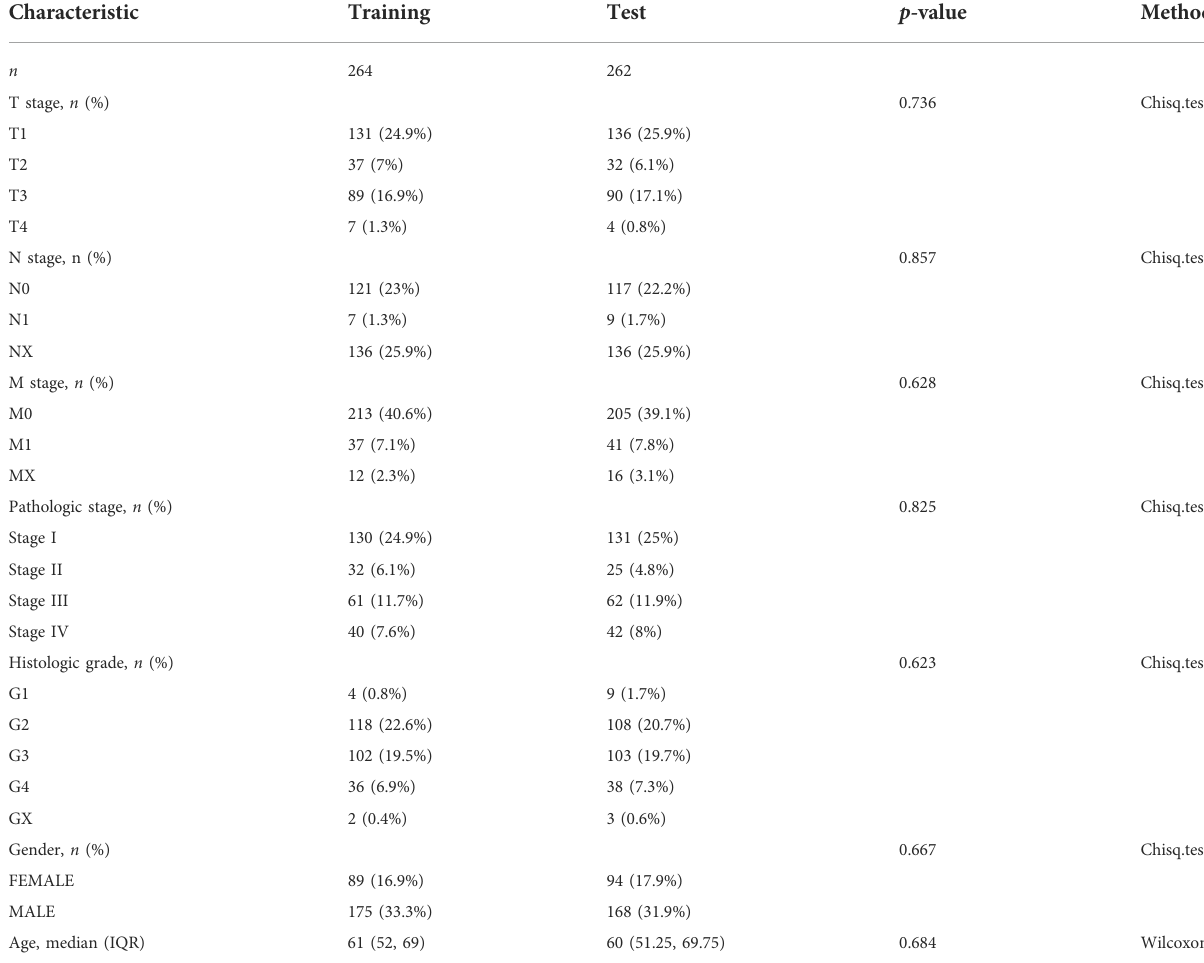
TABLE 1 Clinical information of the training cohort and test